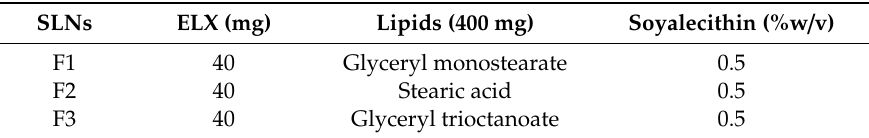
Table 3. Composition of ELX loaded